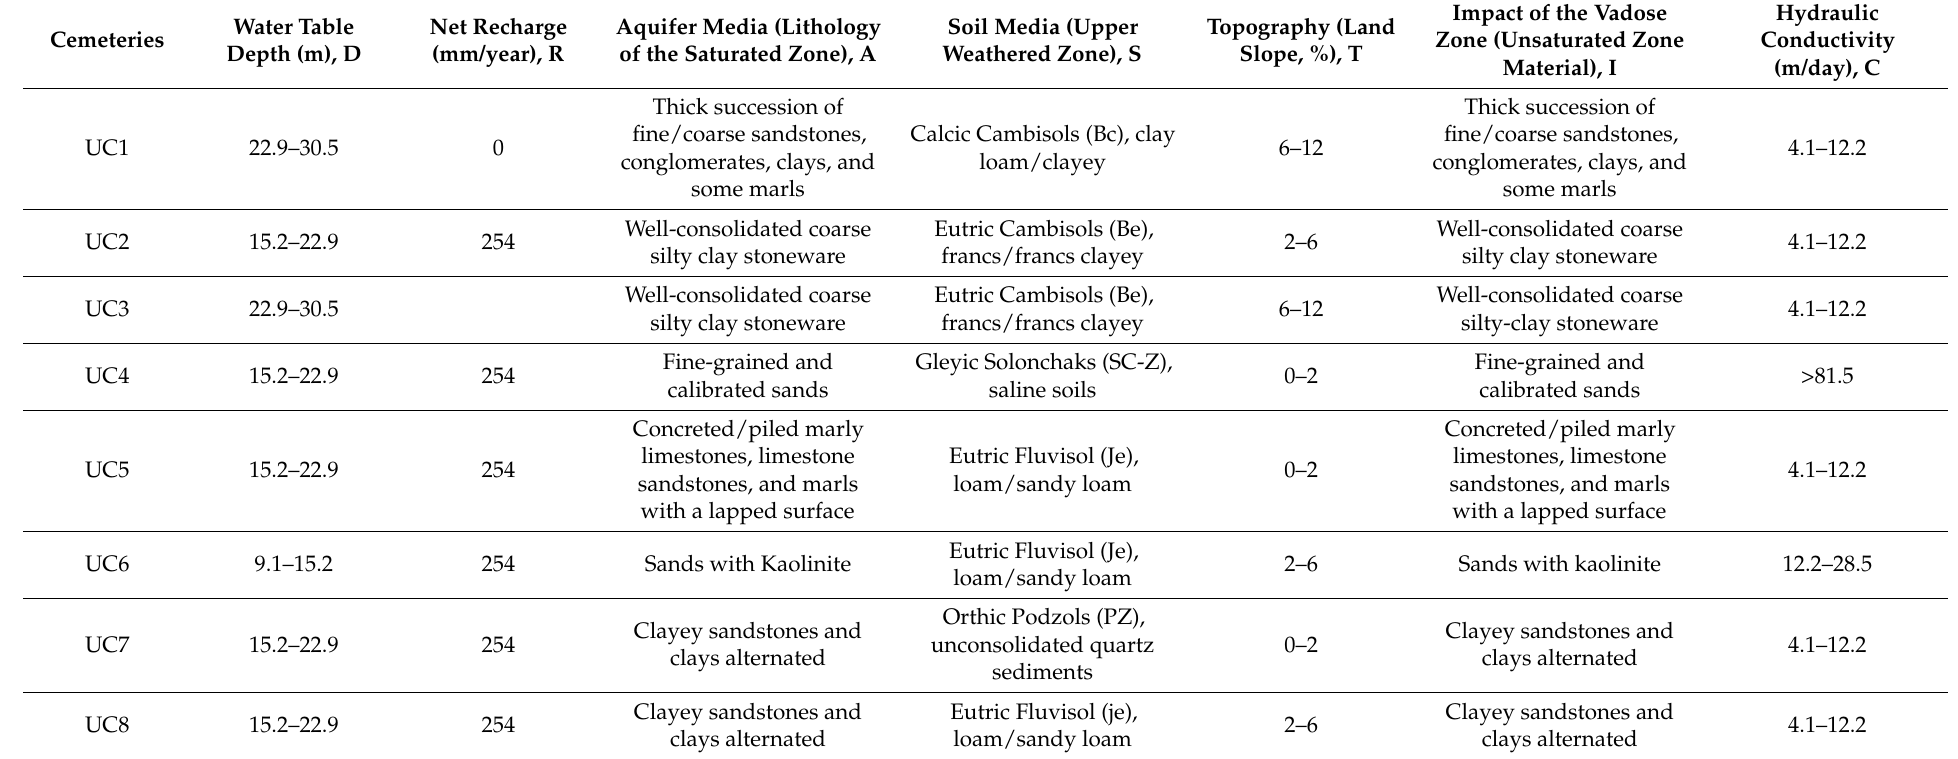
Table 3. Characteristics of cemeteries for the development of thematic DRASTIC